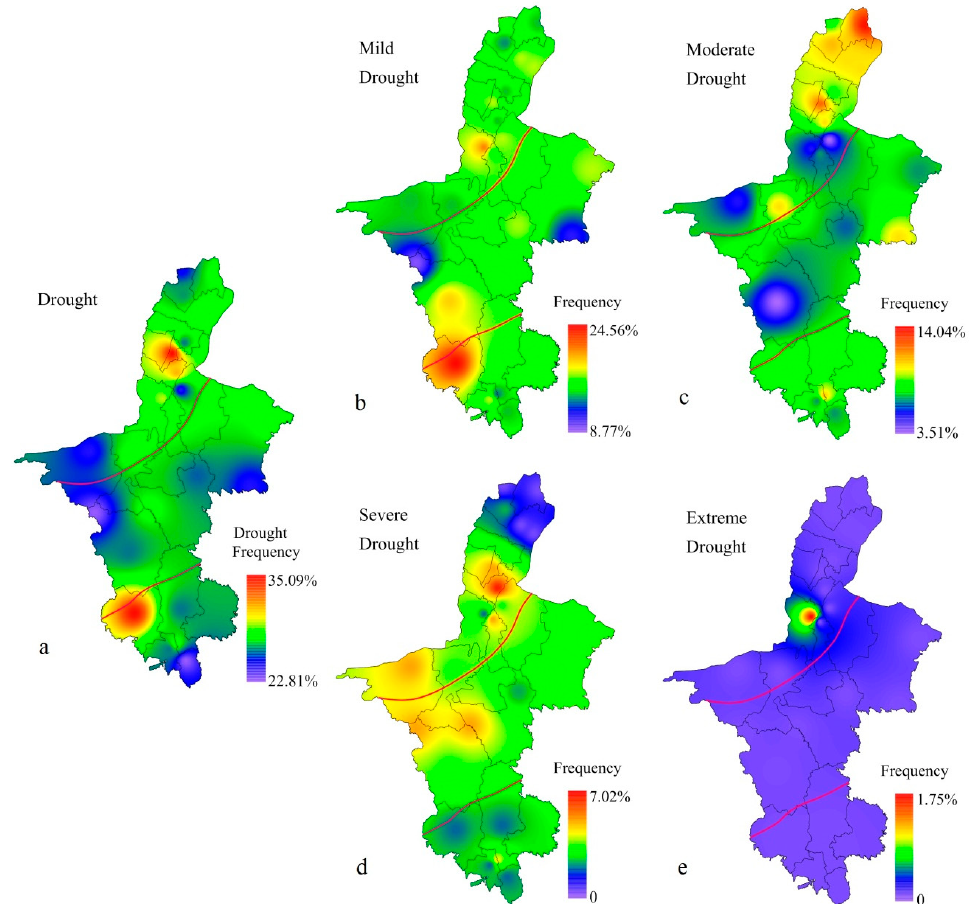
Figure 9. Spatial distribution of drought frequency in different degrees between 1960 and 2016 (the drought frequency was calculated by the SPEI12 values). ( a ) The frequency of the drought; ( b – e ) The frequency of mild, moderate, severe, and extreme droughts.